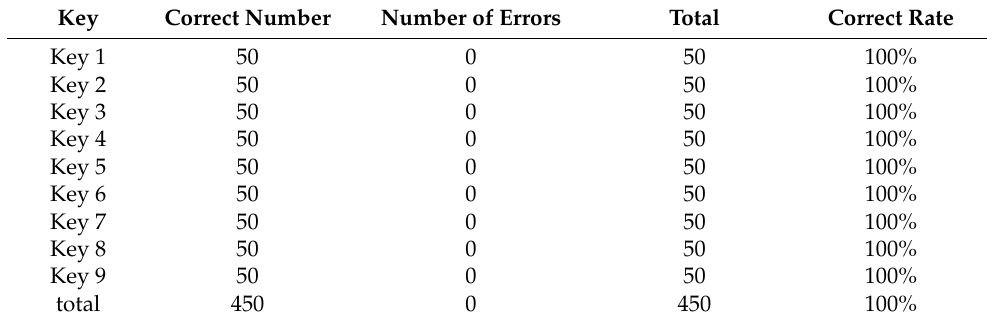
Table 6. Recognition results of key